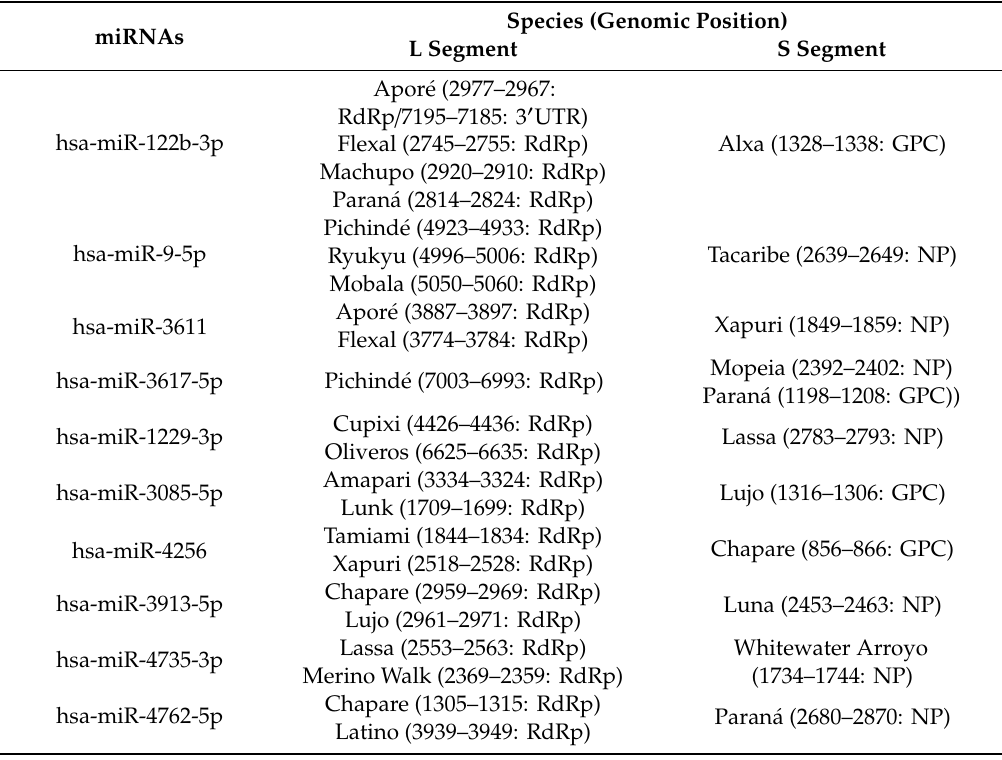
Table 3. List of top 10 miRNAs binding to small (S) and large (L) segments of di ff erent mammarenaviruses.